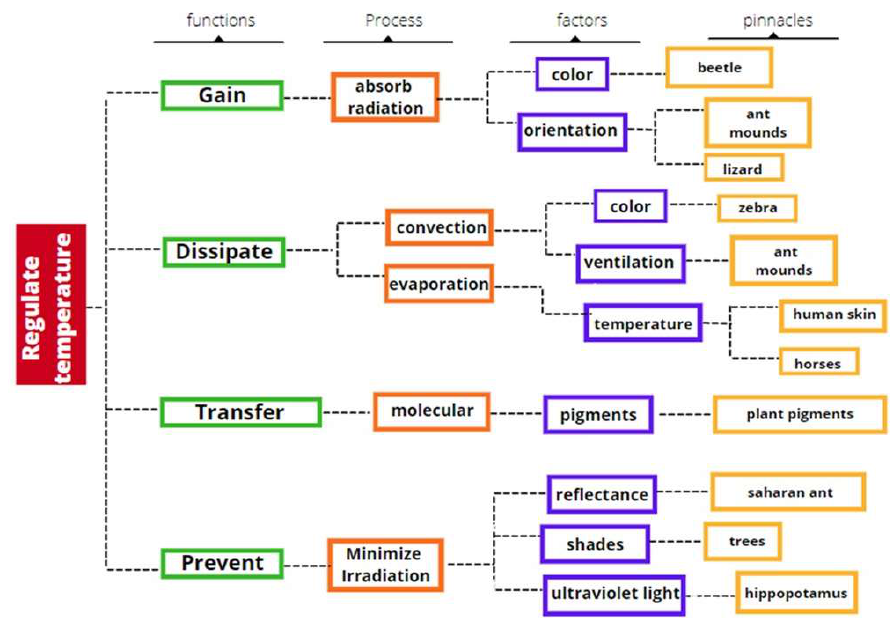
Figure 4. Scanning model for the temperature regulation. Own